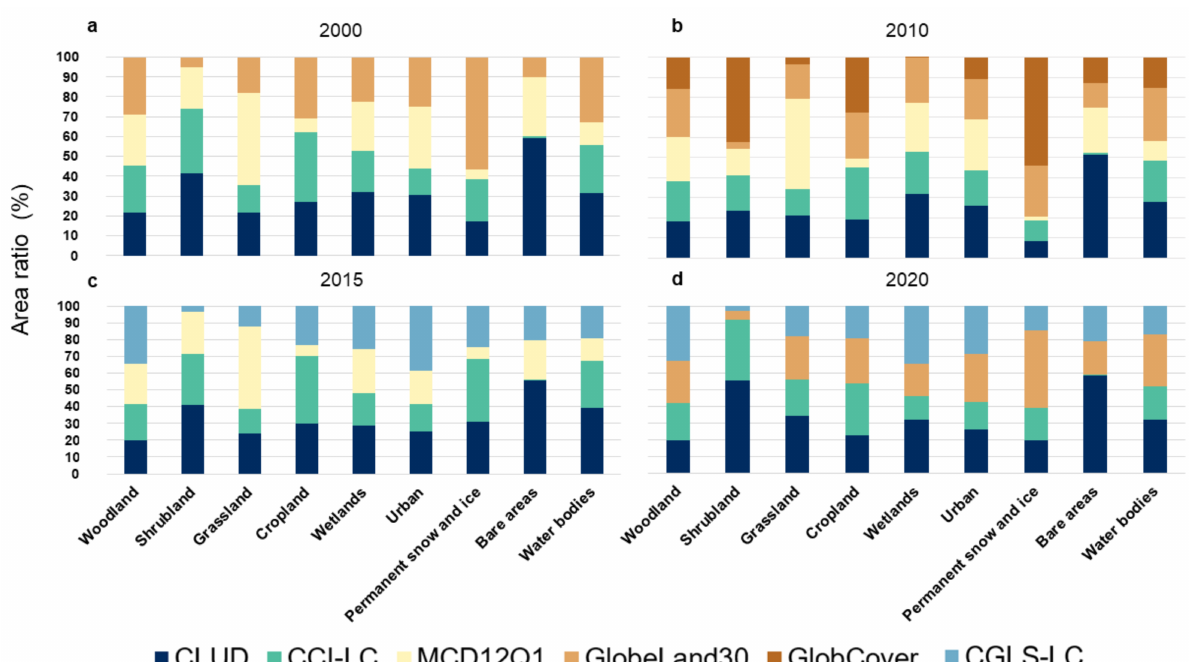
Figure 3. Area ratio of each class type in the six land cover products for epochs ( a ) 2000, ( b ) 2010, ( c ) 2015, and ( d )